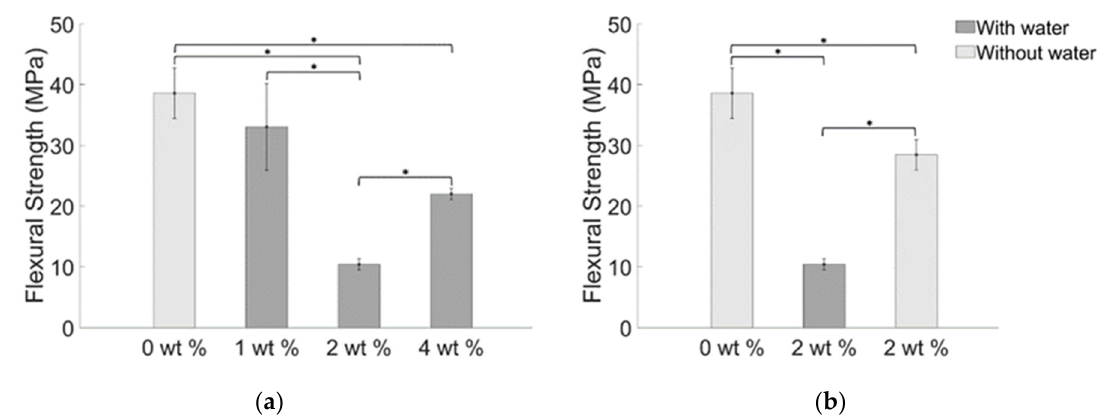
Figure 9. Mean values of flexural strength for BiONP-composite ( a ) with water and ( b ) without water. The bar with the asterisk indicates a statistical difference between the samples ( p < 0.05).